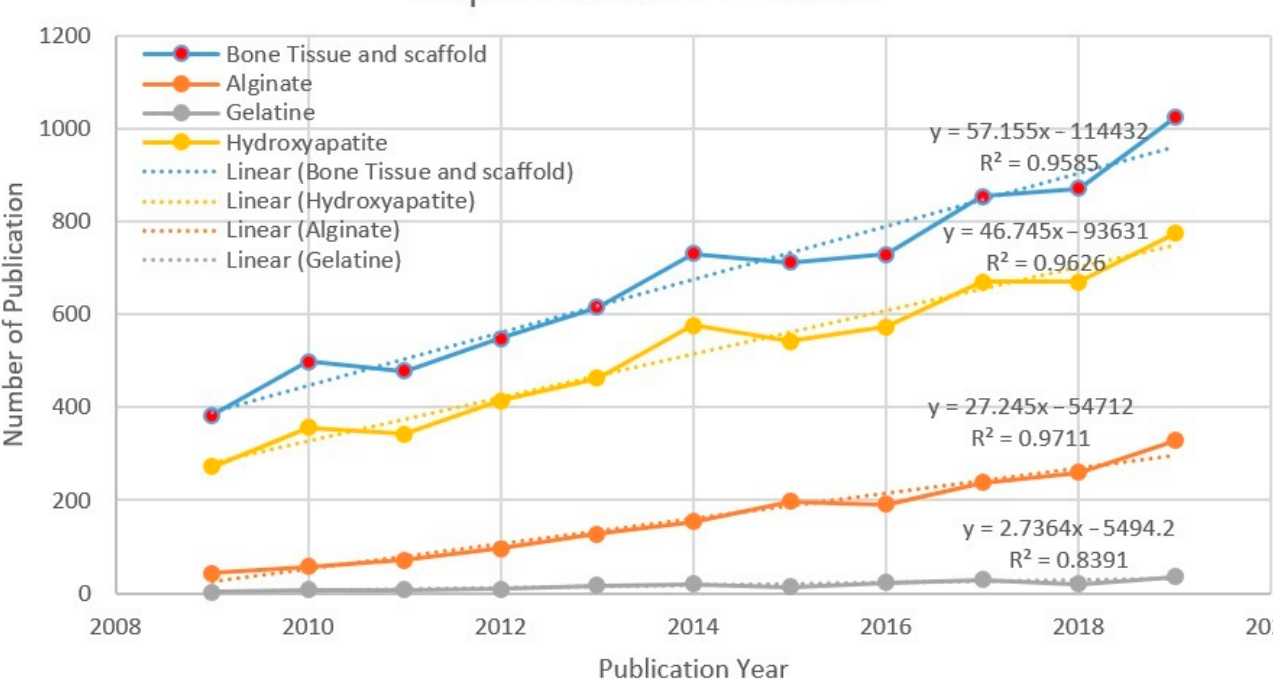
Figure 3. Number of publications per year (2009–2019).